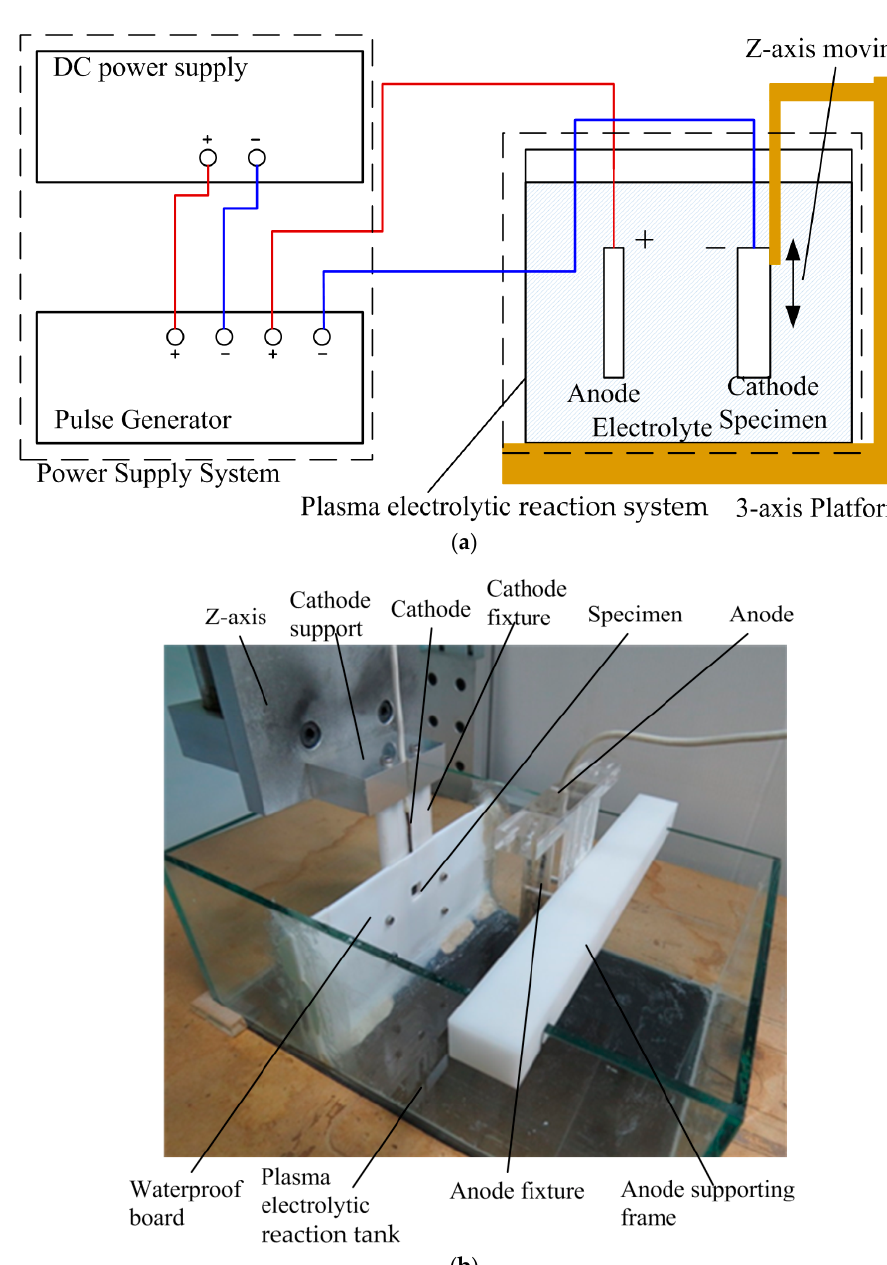
Figure 2. Plasma electrolytic equipment for cleaning the surface of stainless steel 316: ( a ) configuration diagram; ( b ) detailed view of the reaction system components; DC: direct current. diagram; ( b ) detailed view of the reaction system components; DC: direct